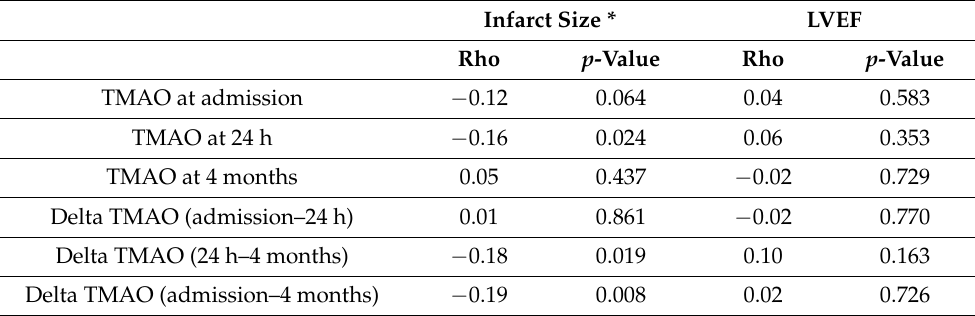
Table 2. Spearman correlations between TMAO and MRI indices 4 months